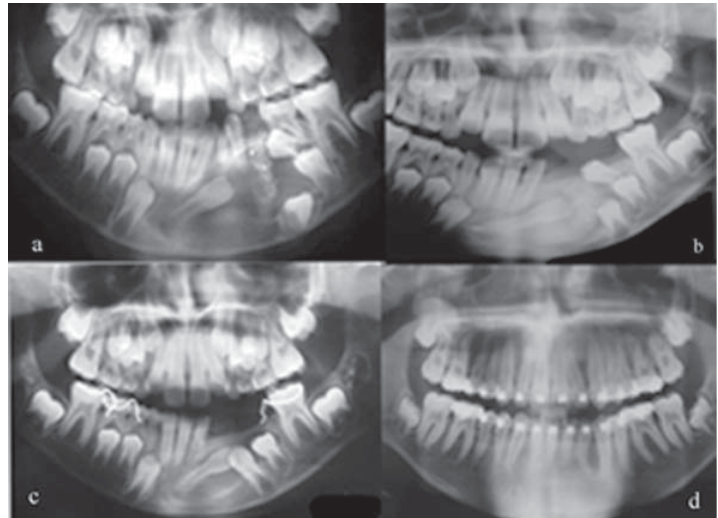
Figure 2 - Panel of panoramic radiographs. (a) Unilocular osteolytic cystic lesion with sclerotic border associated to lateral incisor. Canine and second premolar dislocated apically. Radiopacity of iodoform gauze can be seen. (b) Six-month follow- up radiographic image showing that teeth have erupted spontaneously. (c) One-year follow-up showing that teeth are still in eruption process. Image of space-maintainer installed can be seen. (d) Seven-year radiographic image showed